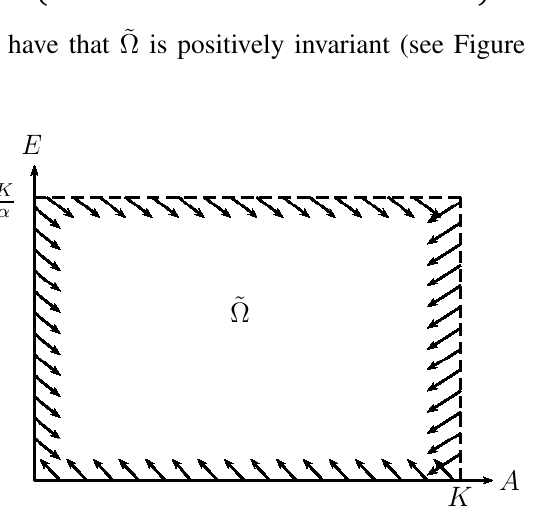
Fig. 4. Region where (4) is positively